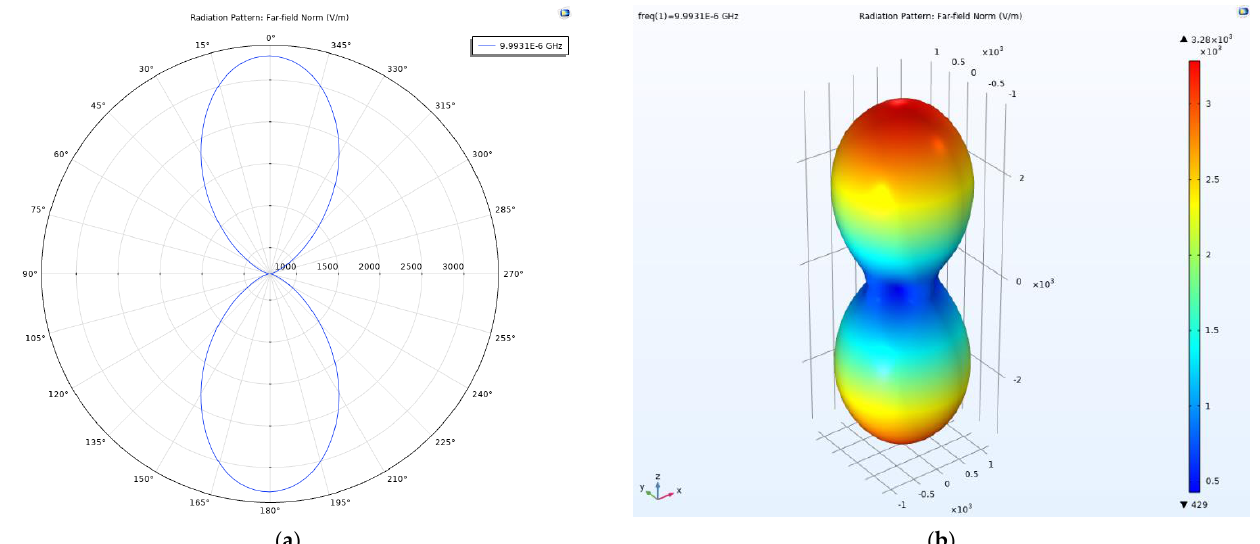
Figure 11. ( a ) Two-dimensional far-field pattern after circular polarization. ( b ) Three-dimensional far-field pattern after circular polarization.